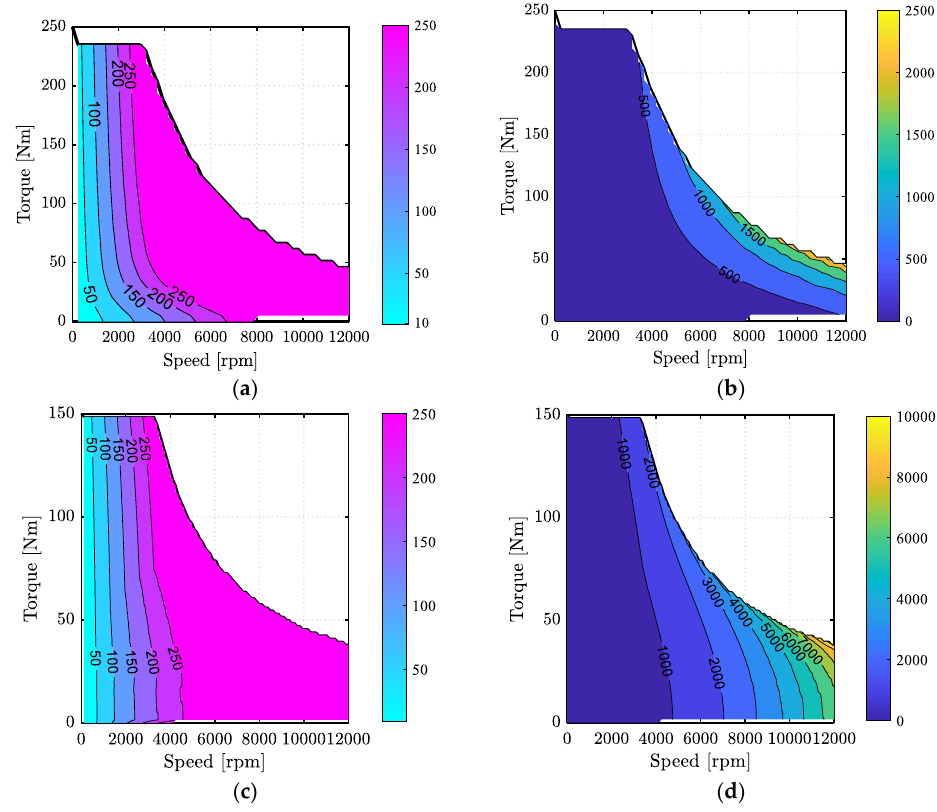
Figure 6. Voltage and core loss maps of a 50 kW IPMSM and 45 kW SPMSM for operation over a wide torque speed range. These plots have been provided based on the collected data from [20,24]. ( a ) voltage map in the torque speed plane for the IPMSM. ( b ) core loss map in the torque speed plane for the IPMSM. ( c ) voltage map in the torque speed plane for the SPMSM. ( d ) core loss map in the torque speed plane for the SPMSM.